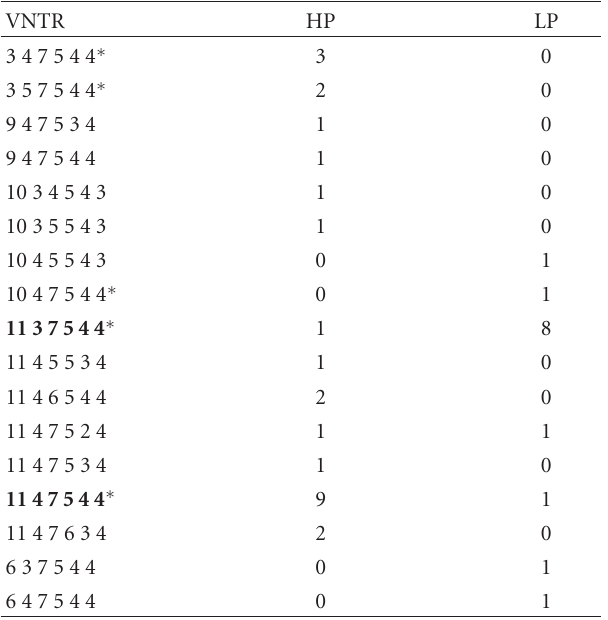
Table 2: VNTR profiles of M. bovis strains bearing the SB0140 spoligotype. Di ff erentially represented strains are highlighted/ italicised. ∗ VNTR types were not unique to individual badgers (see Table